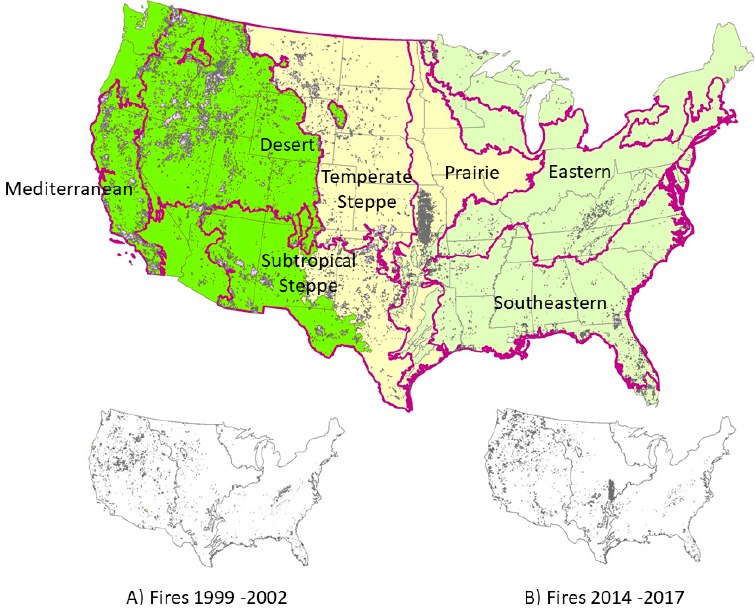
Figure 1. Three regions and seven ecoregions of the conterminous United States with all fires during 1999 to 2017. Below, fires during 1999 to 2002 ( A ) and fires during 2014 to 2017 ( B ). Fire occurrences during 1999 to 2017 were spatially delineated fires of ≥ 200